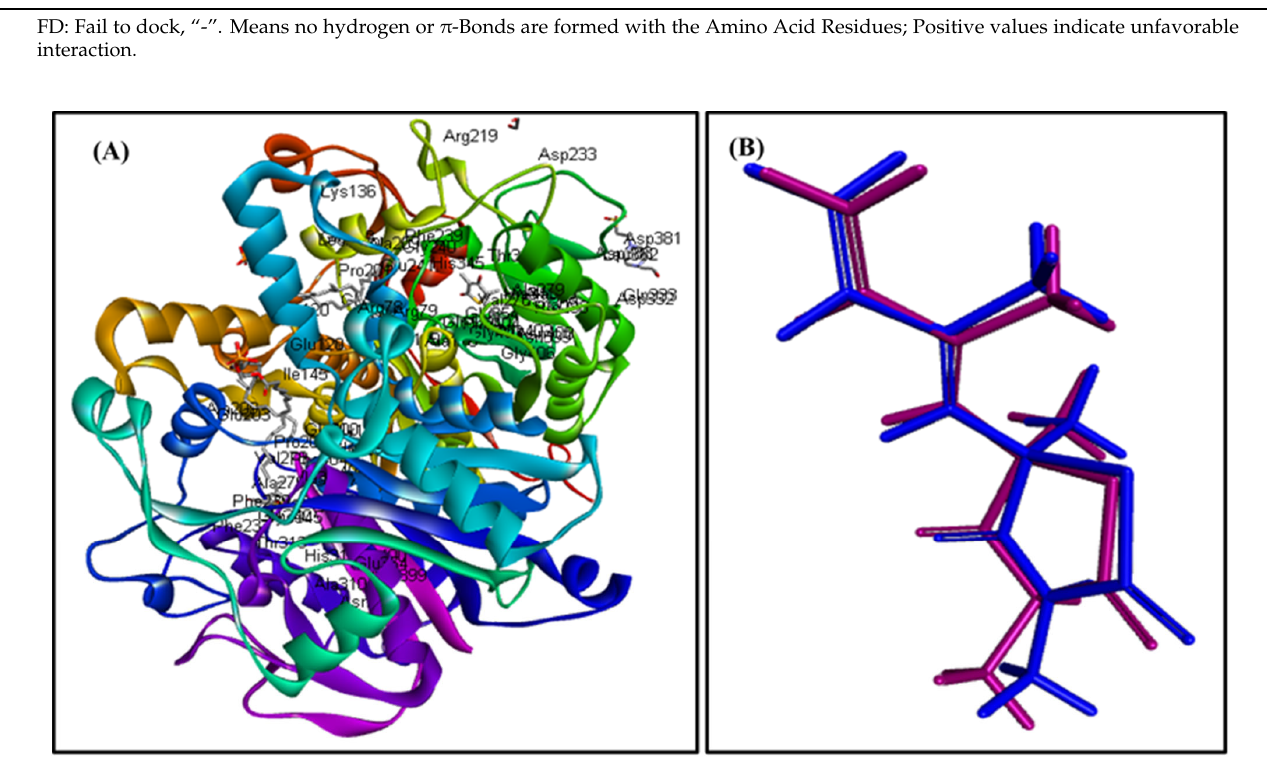
Figure 8. Two ‐ and three ‐ dimensional binding behavior of trans ‐ phytol ( A ) and thiolactomycin; the co ‐ crystalized ligand ( B ) within MTB C171Q receptor KasA inhibitor (4C6X) active site using C ‐ docker protocol.